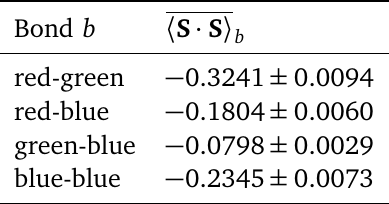
Table 2: Average of the spin-spin correlations for the inequivalent bonds via Eq. (6). The errors are given by the standard deviation of the distribution over the bonds, and the colour labels correspond to the coloured sites in Fig. 1.